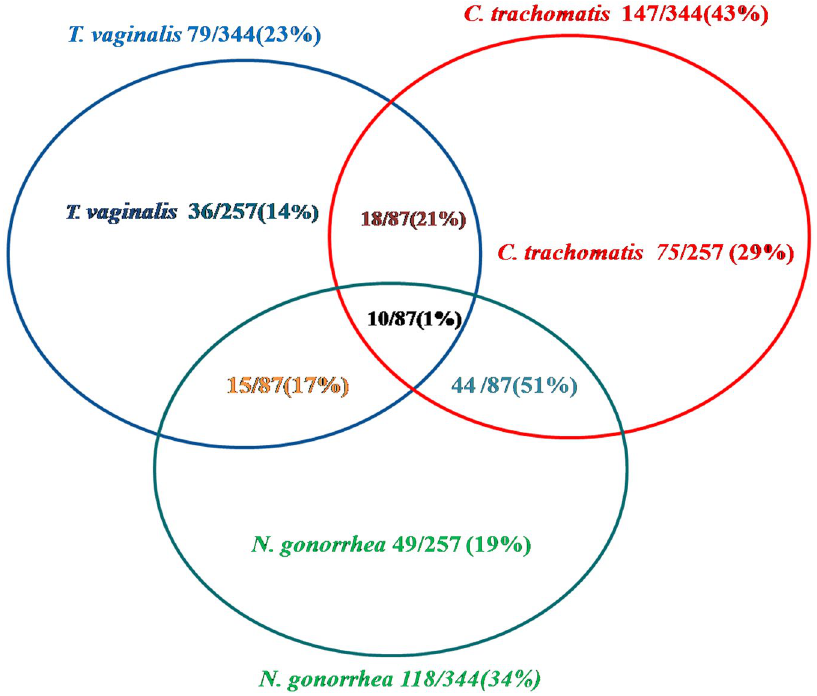
Figure 2. Venn diagram showing prevalence of T. vaginalis , C. trachomatis and N. gonorrhoeae infection as well as co-infection. DNA was isolated from samples collected from symptomatic patients and infection for these three pathogens was determined by PCR based